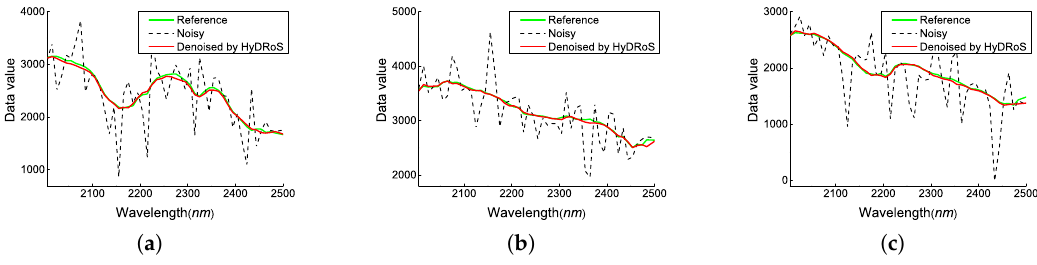
Figure 7. Spectral signatures of the three minerals before and after denoising: ( a ) pixel located at (257, 629) in the ROI of Alunite; ( b ) pixel located at (1359, 1071) in the ROI of Chalcedony; ( c ) pixel located at (157, 503) in the ROI of